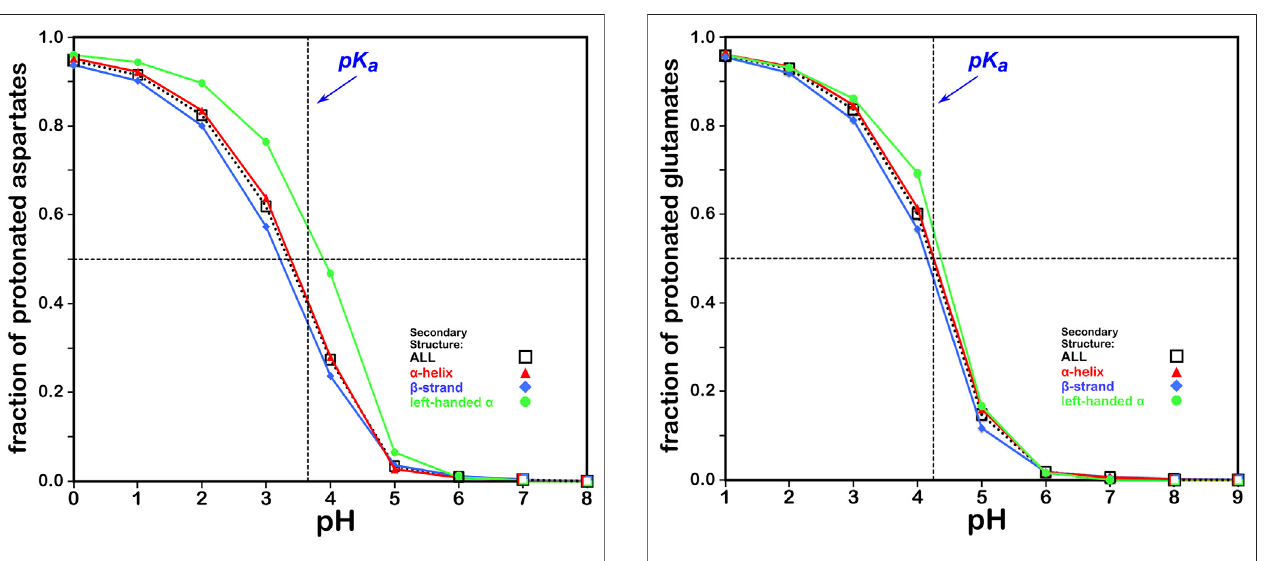
FIGURE 4 | Titration curves of ASP residues by secondary structure. The native pK a for aspartic acid is indicated.